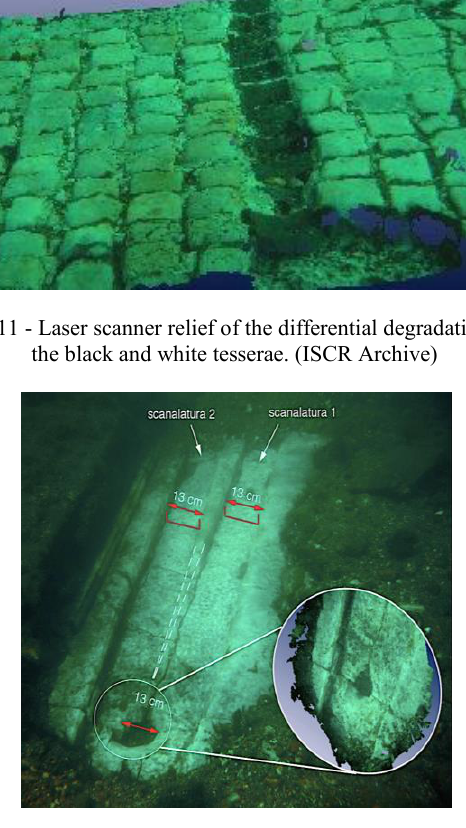
Fig. 12 - Treshold of a sliding door and its detailed laser scanner relief in the circle. (ISCR